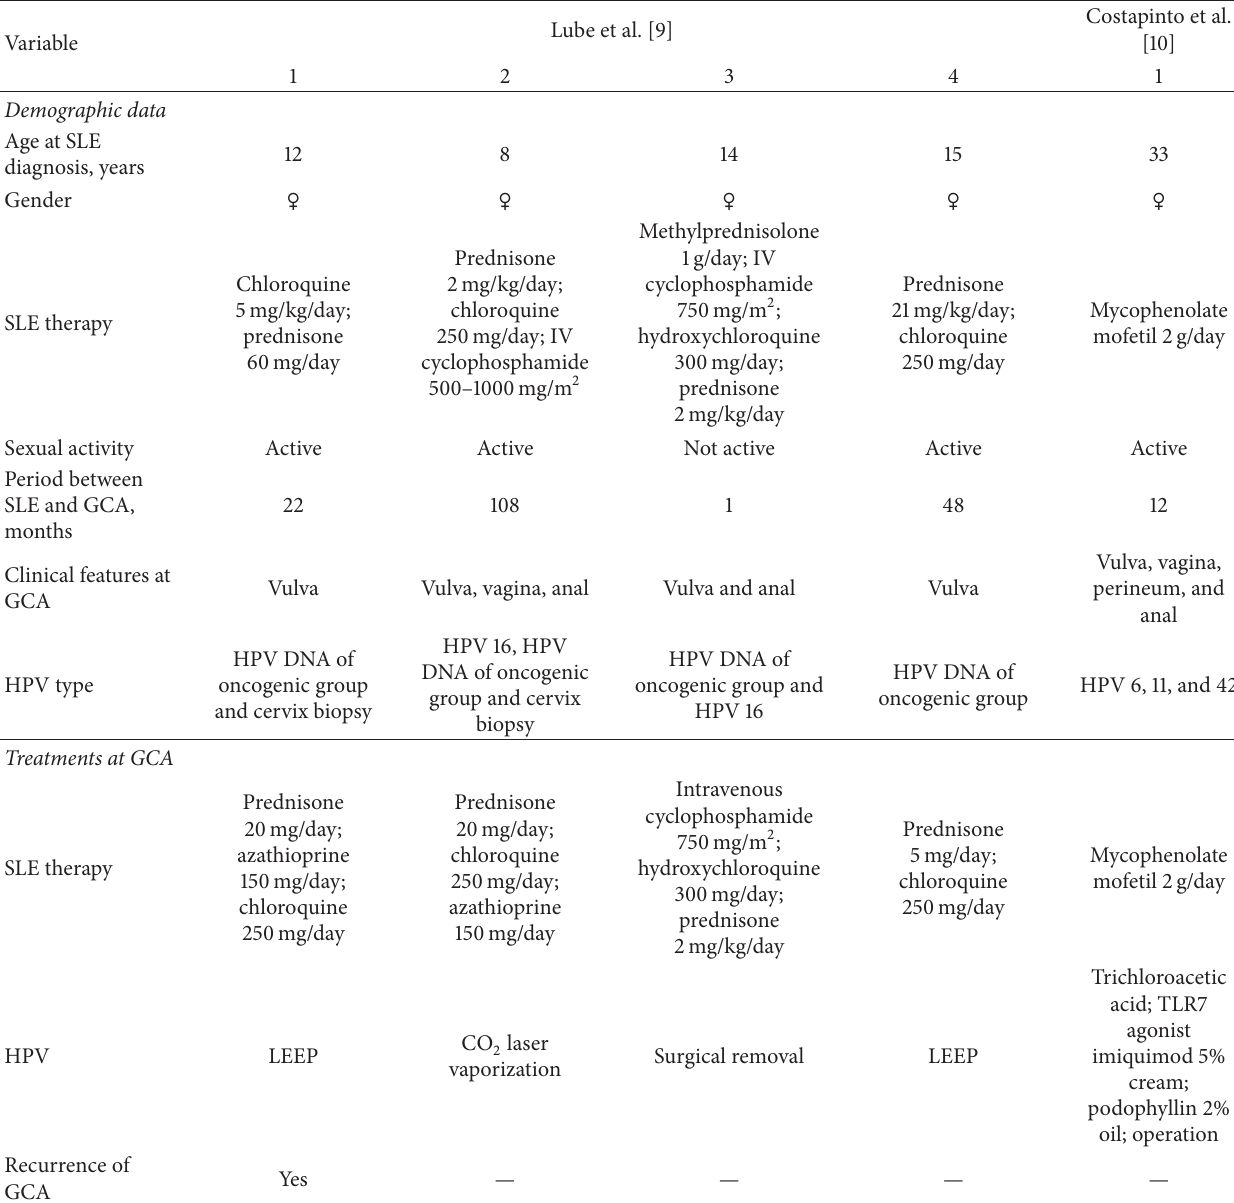
Table 2: Characteristic of each patient in both